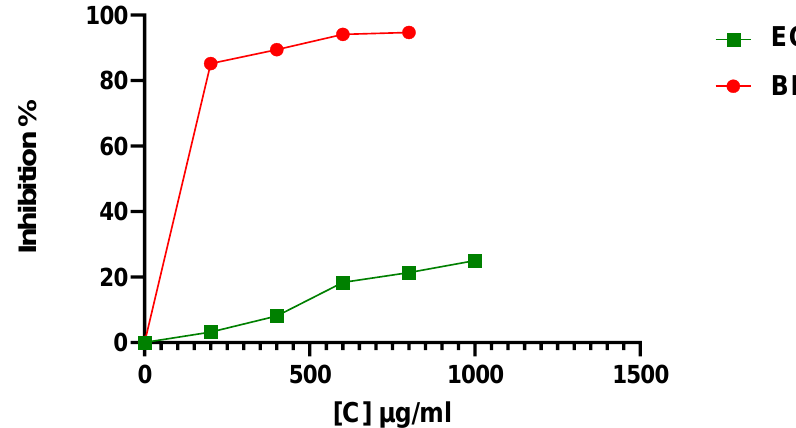
Figure 1. Percentage inhibition of DPPH by different concentrations of Taraxacum officinale essential oil and the standard BHT. Results are expressed as means ± SD of three parallel measurements p < 0.01. BHT: butylated hydroxytoluene; EO: essential oil.